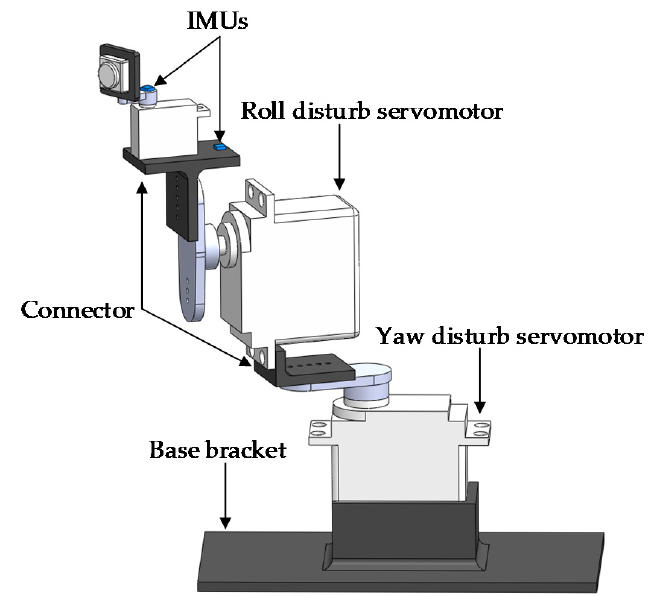
Figure 5. The schematic diagram of the experimental platform.